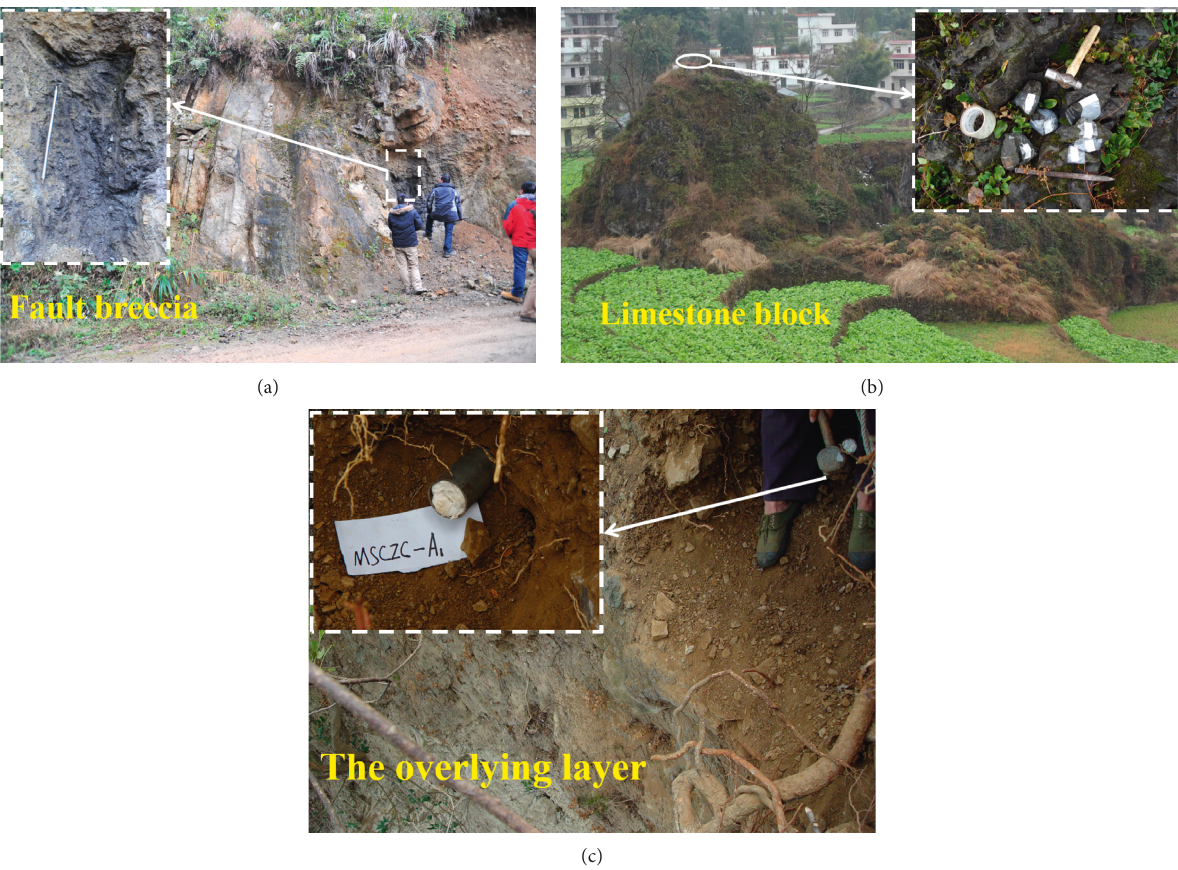
Figure 3: On-site photos of samples. (a) The ESR test, (b) the 36 Cl exposure test, and (c) the OSL test.